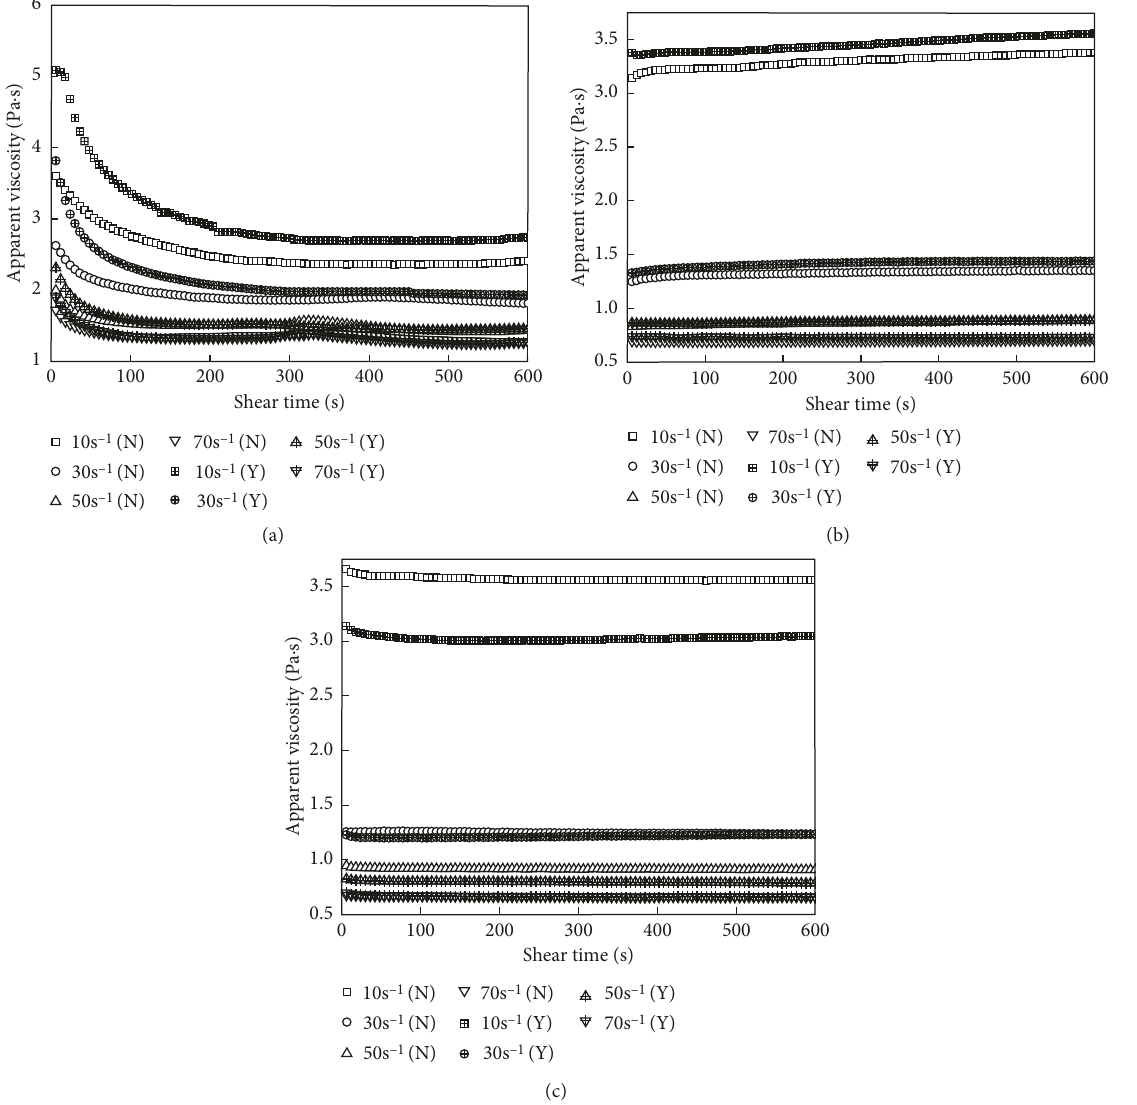
Figure 2: Changes of apparent viscosity: (a) FTS; (b) UTS; (c) STS (N means no APAM addition; Y means with optimal APAM